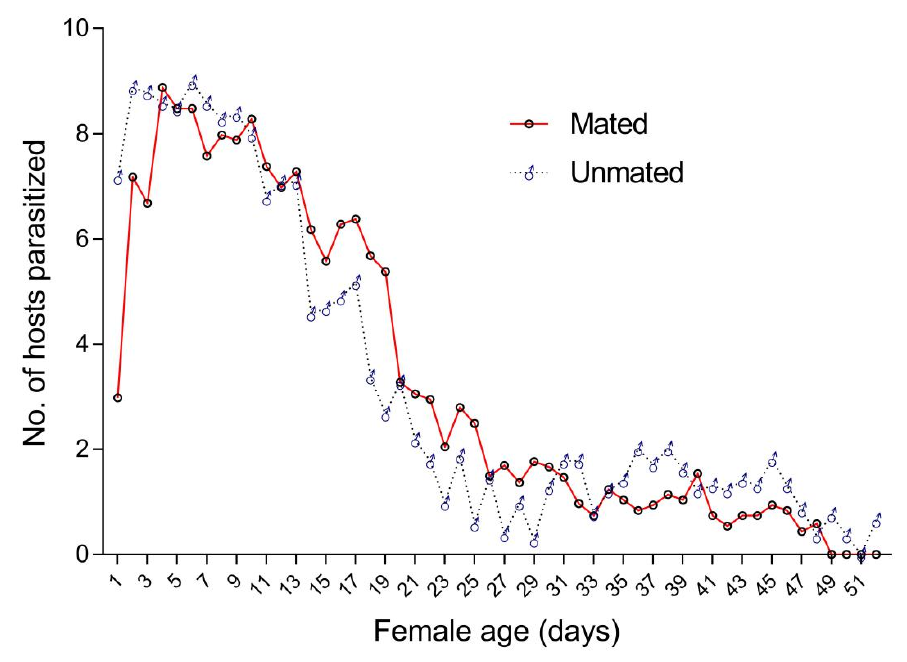
Figure 2. Number of hosts parasitized by mated and unmated T. drosophilae females over their life-times.